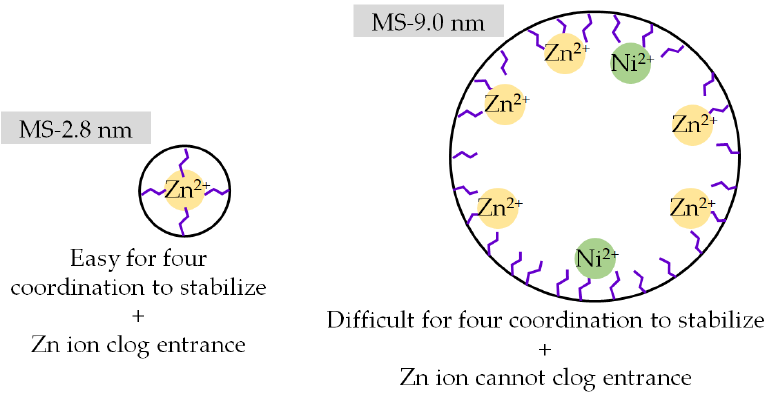
Figure 12. Illustration on anticipated adsorption of Zn and Ni on amine-modified MS with different initial MS pore sizes in binary systems.